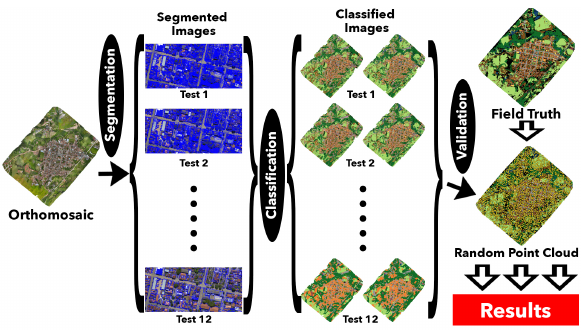
Figure 4. Methodology